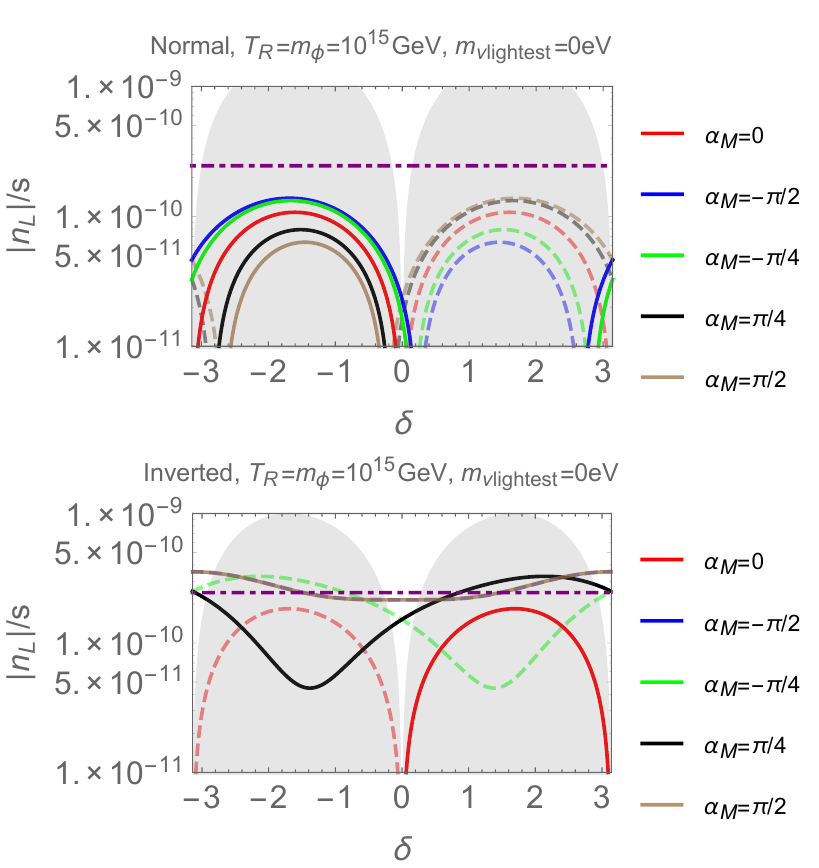
Figure 7 . Lepton asymmetry dependence on (cid:14) with T R = m (cid:30) = 10 15 GeV ; B = 1, for in(cid:13)aton decay dominantly to Higgs boson. The uncertainty for (cid:11) M = 0 case is shown in the gray bands. to the latter case. In the latter case, y 2